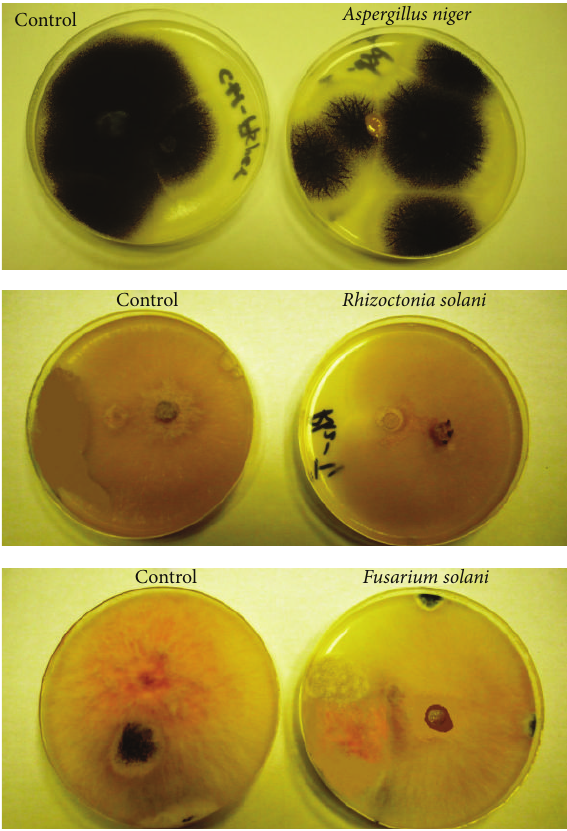
Figure 14: Antifungal activity of